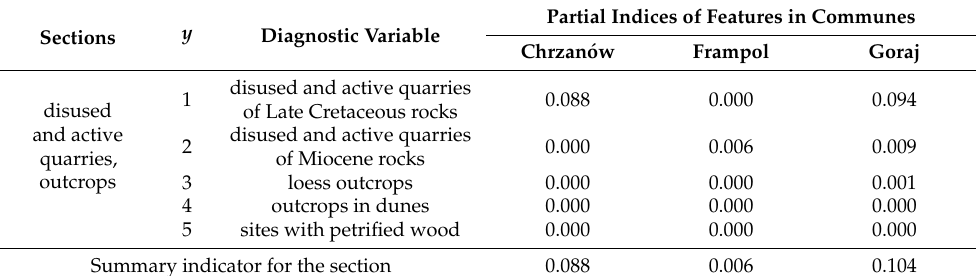
Table 4. Examples of partial indices of the geotourism potential calculated for the disused and active quarries and outcrops section in some communes.